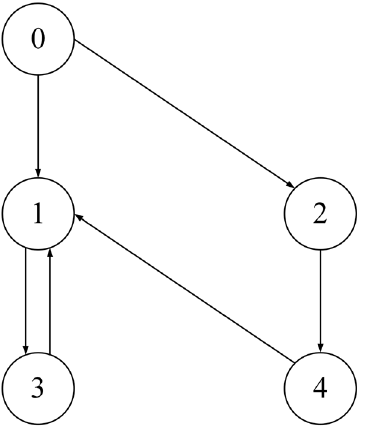
Figure 1. Communication topology.